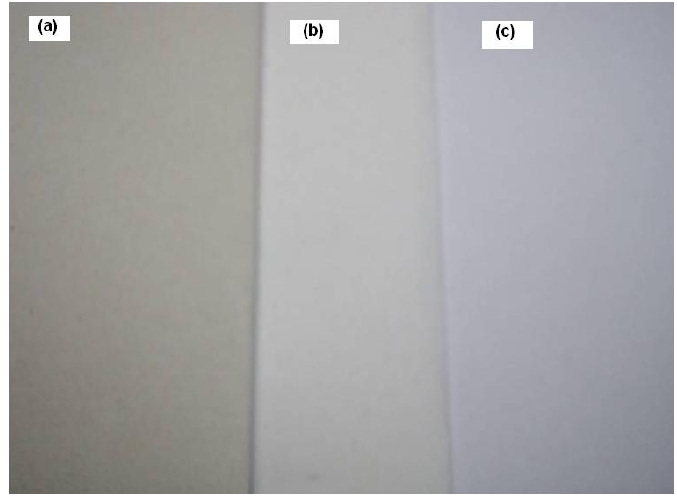
Figure 24. Photos of the recycled papers made from three kinds of waste pulp [(a) old newspaper, (b) white ledger, and (c) printing paper] through in-situ process with PCC (10% calcite): whiteness order (a) < (b) < (c) (unpublished